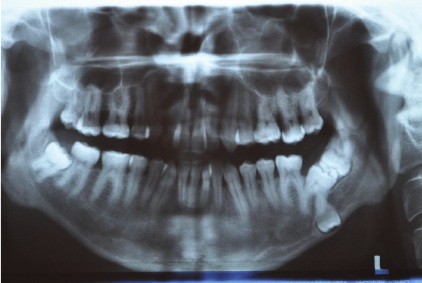
Figure 1: Preoperative panoramic radiography.